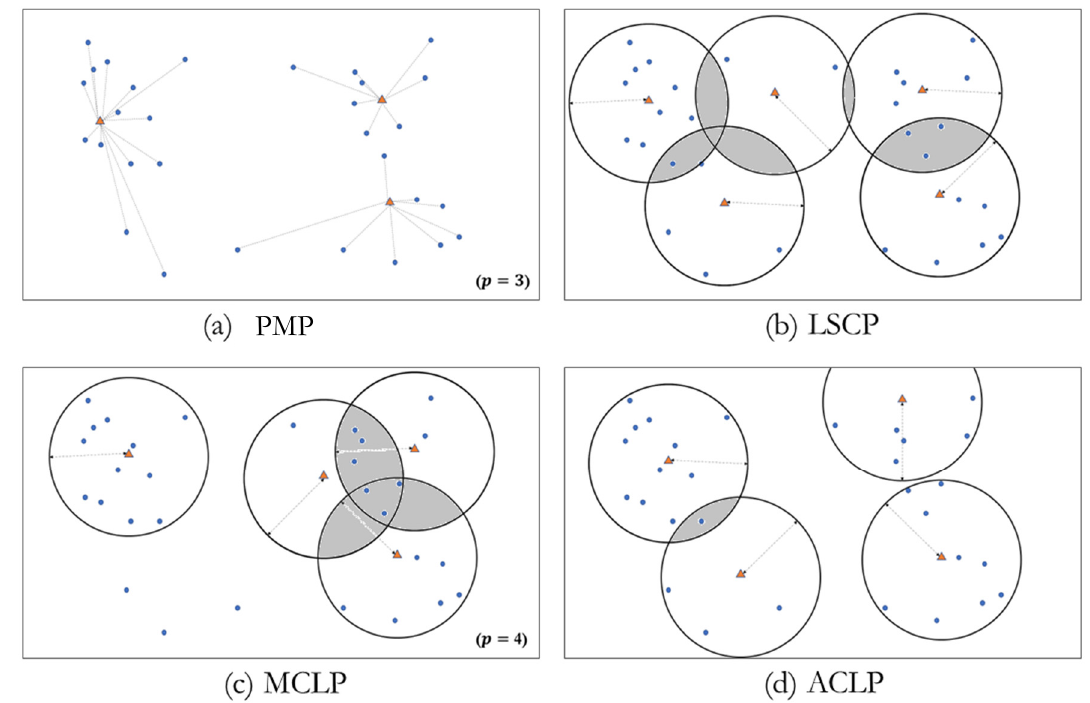
Figure 2. Difference of spatial arrangement of facility coverages among ( a ) PMP, ( b ) LSCP, ( c ) MCLP, and ( d ) ACLP.